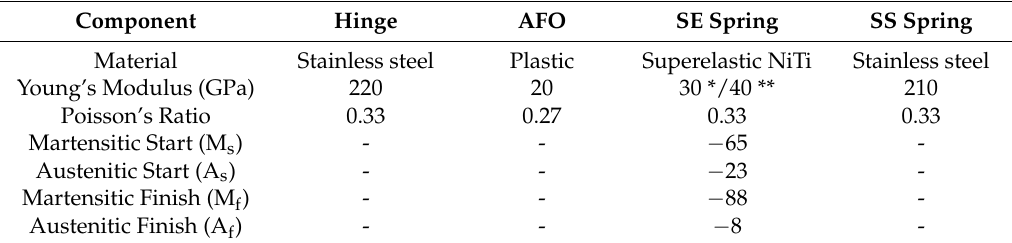
Table 2. Material properties of the model components [40,41].